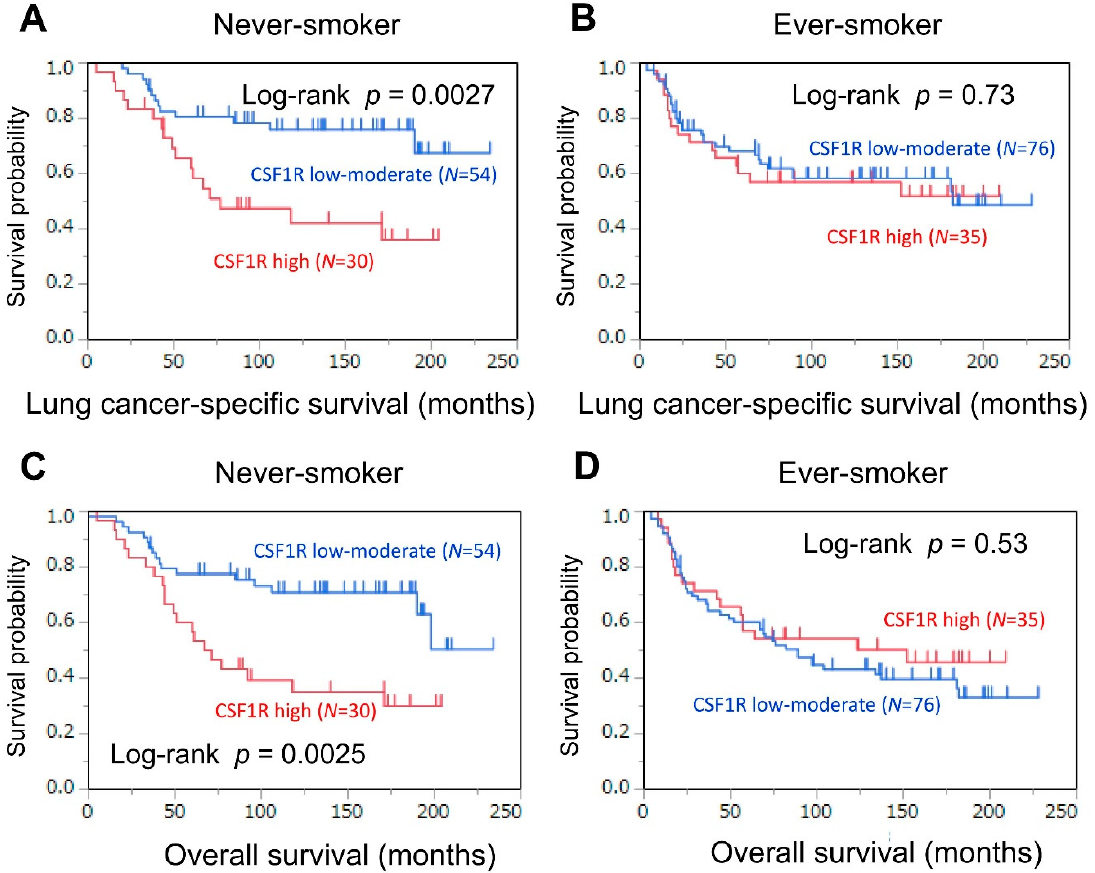
Figure 3. Kaplan–Meier curves for lung cancer-specific ( A ) and overall ( C ) survival, according to CSF1R expression status in tumor-associated macrophages (low–moderate vs. high), in never-smoking patients. Kaplan–Meier curves for lung cancer-specific ( B ) and overall ( D ) survival, according to CSF1R expression status in tumor-associated macrophages (low–moderate vs. high), in ever-smoking patients.